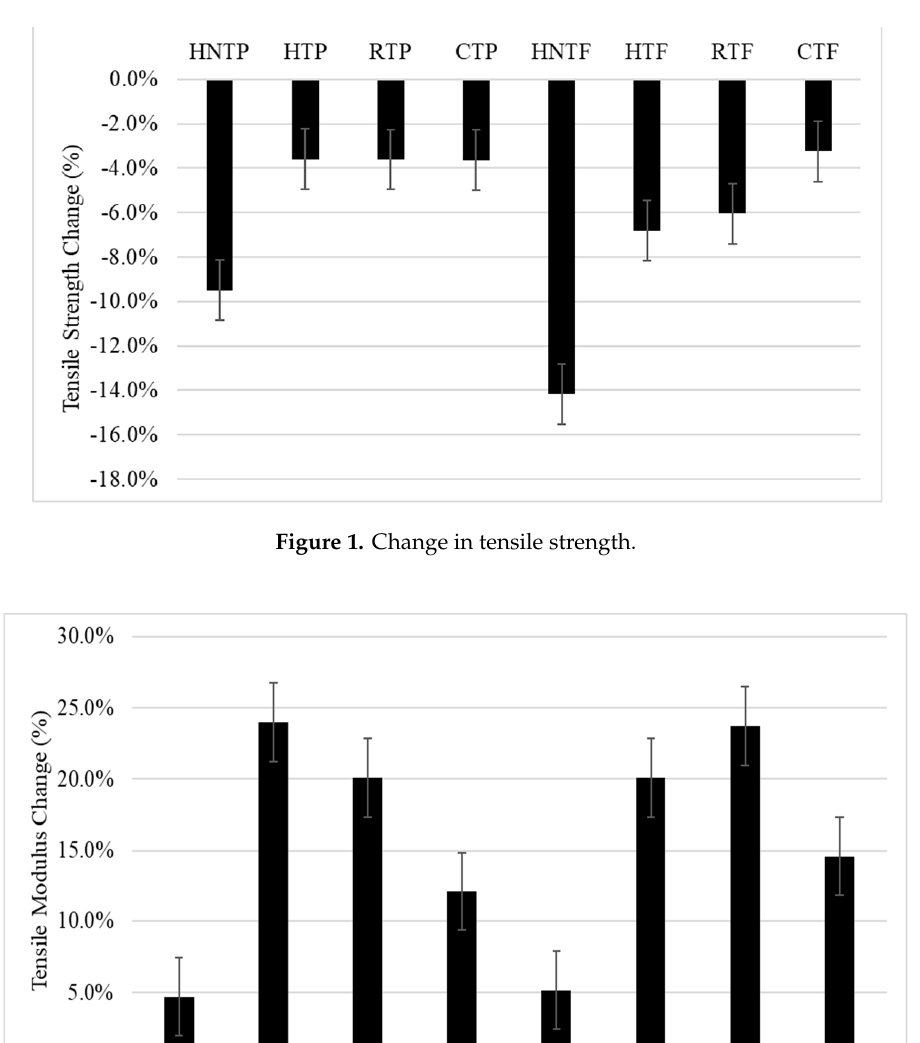
Figure 2. Change in tensile modulus.